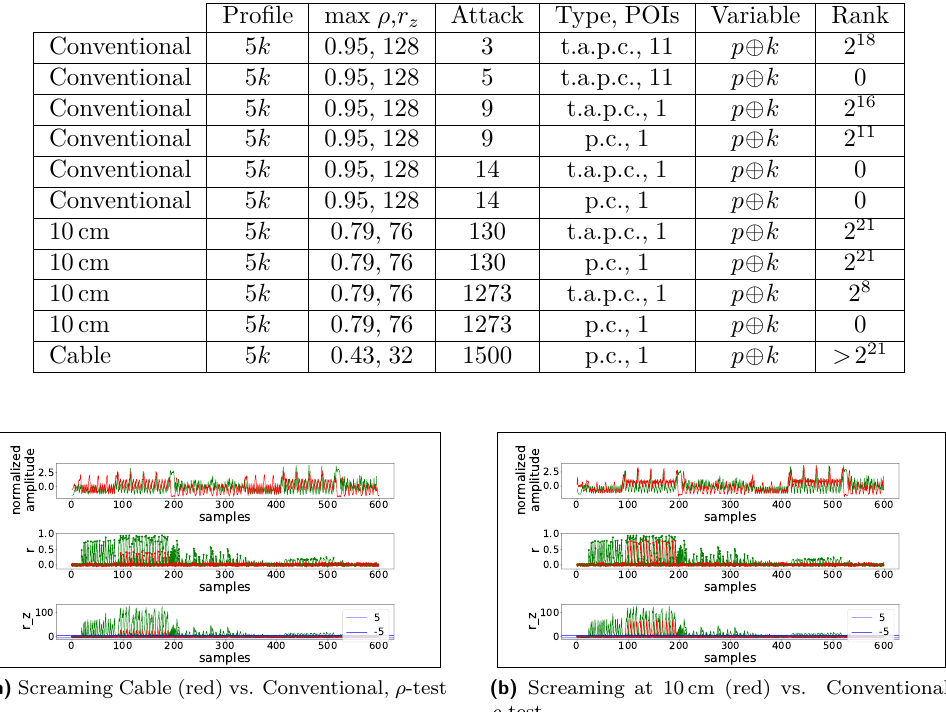
Table 1: Summary of the attacks in the conventional, screaming-channel via cable, and screaming-channel at 10 cm settings. All trace numbers should be multiplied by 500. p.c. stands for profiled correlation, and t.a.p.c. stands for template attack with pooled covariance. The rank was computed with enumeration. The higher correlation and number of POIs result in better attacks for the conventional setting, as expected.